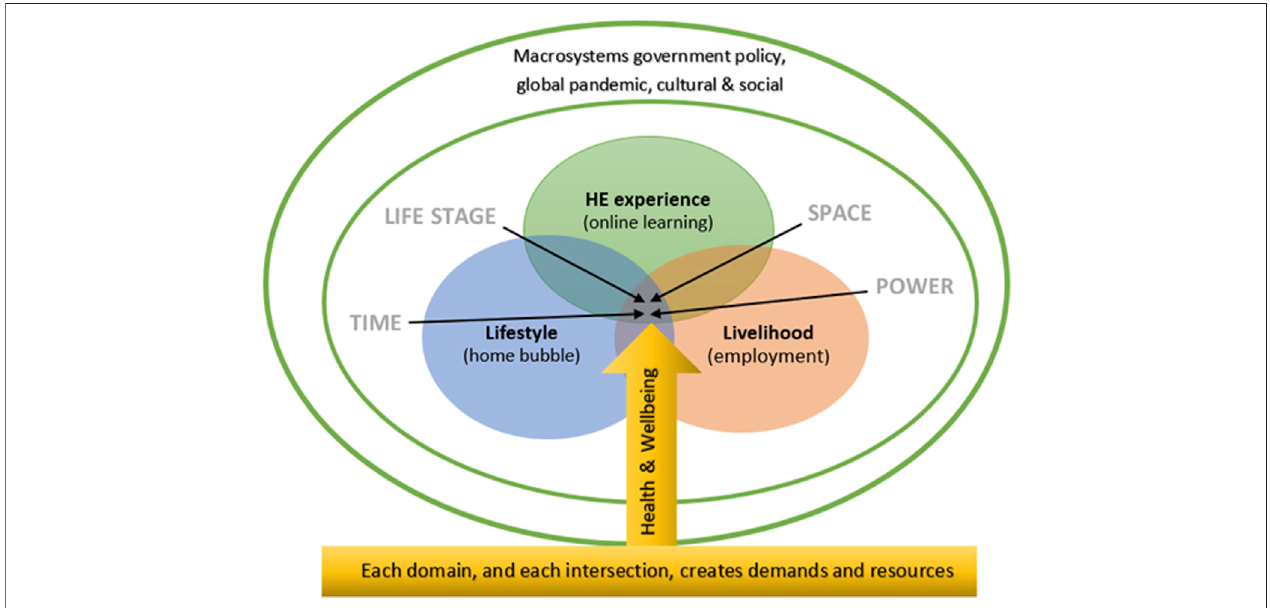
FIGURE 2 | A socio-ecological systems (SEC) model highlighting the multifaceted in fl uences and interactions of Higher Education experiences, livelihood, and lifestyleon an individual ’ shealth and wellbeingduring aglobalpandemicphenomenon. Note: Based onPocock et al. (2012) SEC model of work, home and community.